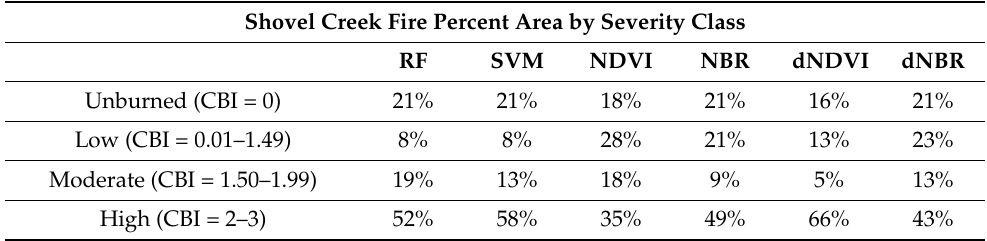
Table 7. Percent area of each burn severity class by product for the Shovel Creek